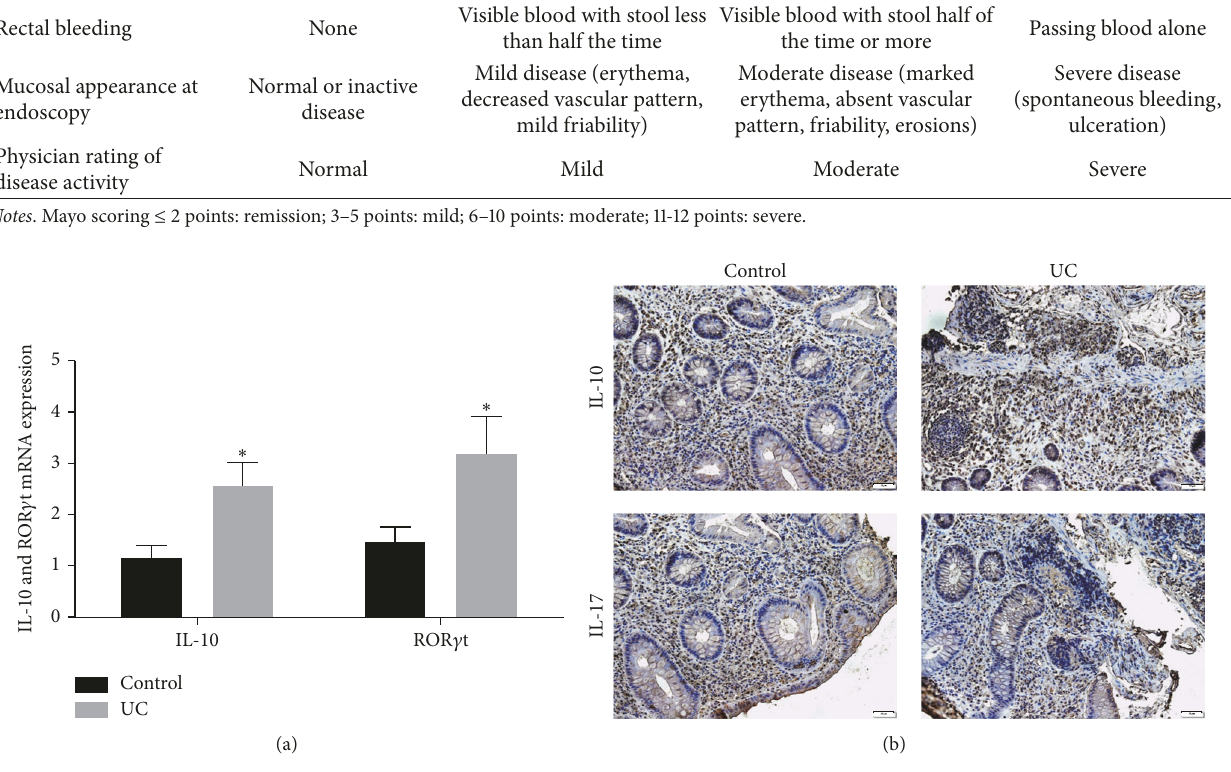
Figure 3: The expression of IL-10 and ROR 𝛾 T in ulcerative colitis patients and healthy subjects was upregulated. (a) The mRNA expression levels of IL-10 and ROR 𝛾 T were determined with qRT-PCR. (b) IL-10 and IL-17 expression by immunohistochemistry. Compared with control group, ∗ 𝑃 < 0.05 .